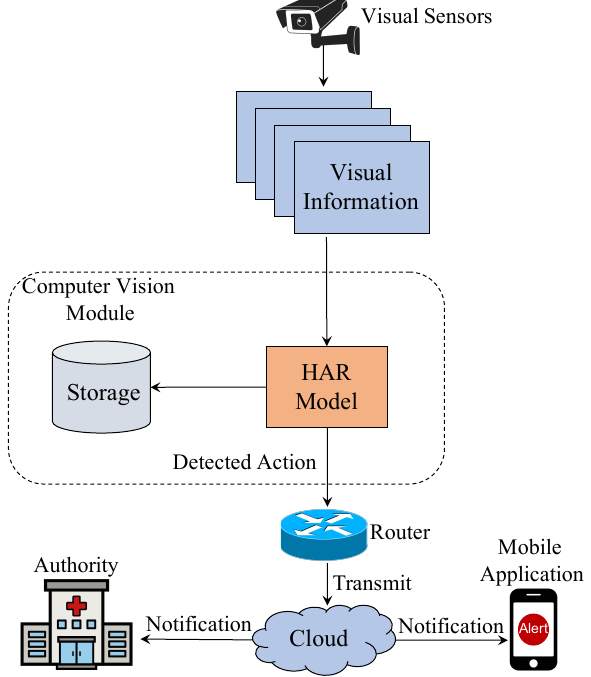
Figure 1. A smart healthcare system for real-time patient